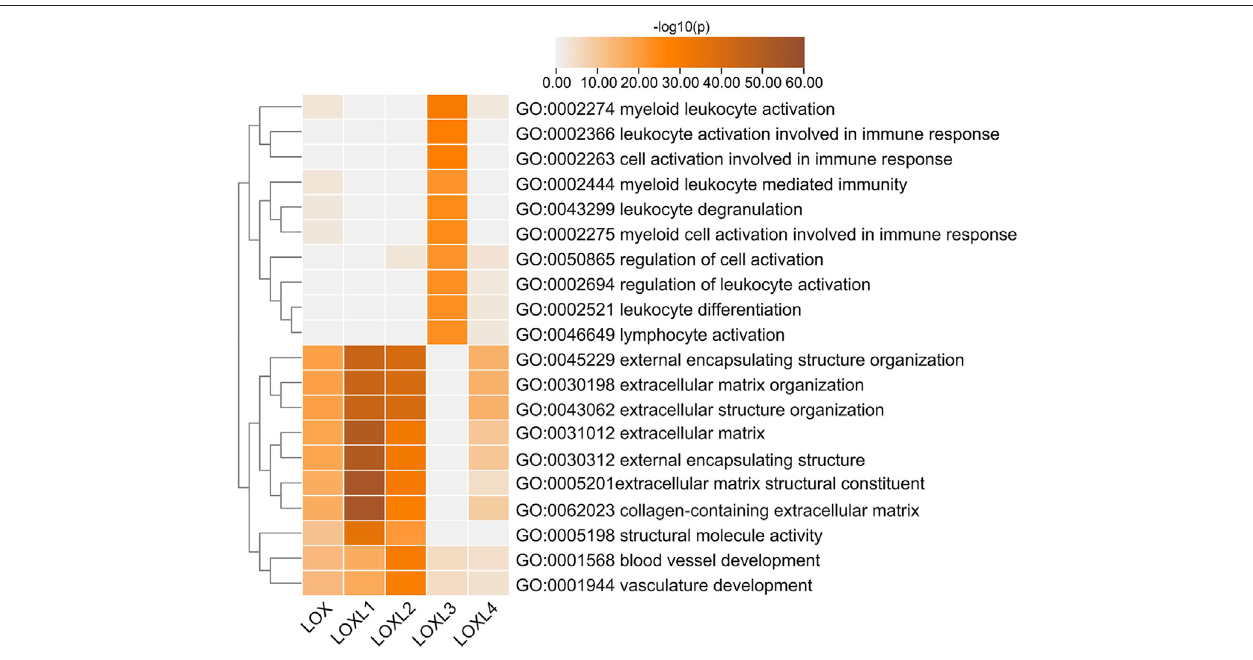
FIGURE 7 | The Venn diagram represents the correlated genes of LOXs based on the Pearson correlation coef fi cient.